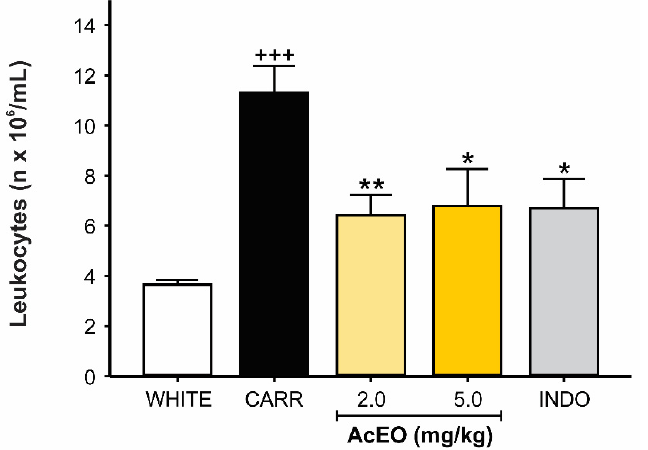
Figure 6. Effect of Aniba canelilla essential oil (AcEO; 2.0 and 5.0 mg/kg; ip.) on peritoneal fluid protein concentration of rats submitted to carrageenan (CARR)-induced (0.3 mg/kg) peritonitis. Data expressed as mean ± SEM ( n = 5–6/group). +++ p < 0.001 vs. white group; *** p < 0.001 vs. CARR group; ** p < 0.01 vs. CARR group. One-way ANOVA followed by Dunnett’s test. 3.3.2. AcEO Reduces Leukocyte Migration into the Peritoneal Cavity Carrageenan administration induced a significant increase in peritoneal fluid leukocyte count (11.32 ± 1.05 × 10 6 ) when compared to white group (3.94 ± 0.25 × 10 6 ). Treatment with AcEO (2.0 and 5.0 mg/kg), however, inhibited carrageenan-induced leukocyte mi- gration (6.42 ± 0.81 × 10 6 and 6.78 ± 1.49 × 10 6 ), promoting levels equivalent to those of indomethacin (6.7 ± 1.18 × 10 6 ) (Figure 7).